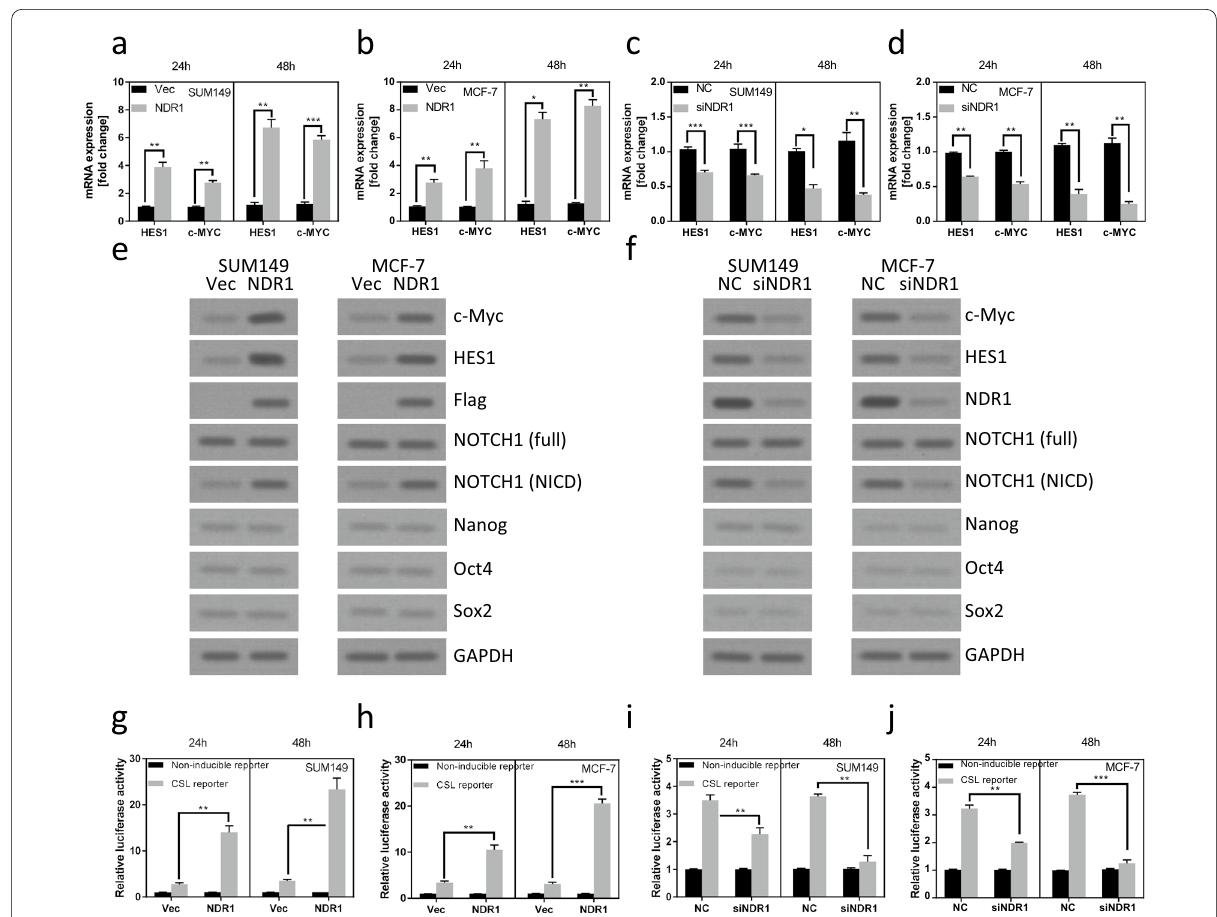
Fig. 3 NDR1 increases Notch1 signaling activity in breast cancer cells. a , b NDR1 or control vector were expressed in SUM149 or MCF‑7 cells for 48 h. Cells were harvested and subjected to Real‑time PCR analysis. c , d NDR1 siRNA or control siRNA were transfected in SUM149 or MCF‑7 cells for 48 h. Cells were harvested and subjected to Real‑time PCR analysis. e NDR1 or control vector were expressed in SUM149 or MCF‑7 cells for 48 h. Cells were harvested and subjected to western blot analysis. f NDR1 siRNA or control siRNA were transfected in SUM149 or MCF‑7 cells for 48 h. Cells were harvested and subjected to western blot analysis. g , h Luciferase reporter (Notch1 or control) and Renilla reporter were transfected into SUM149 or MCF‑7 cells for 12 h. Then, NDR1 or control vector was expressed in SUM149 or MCF‑7 cells for 48 h. Cells were harvested and subjected to luciferase reporter assay. i , j Luciferase reporter (Notch1 or control) and Renilla reporter were transfected into SUM149 or MCF‑7 cells for 12 h. Then, NDR1 siRNA or control siRNA were transfected in SUM149 or MCF‑7 cells for 48 h. Cells were harvested and subjected to luciferase reporter assay. The bar represents mean SD of three independent experiments (*: p < 0.05, **: p < 0.01, ***: p < ±